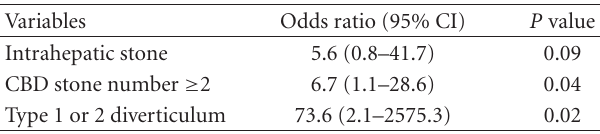
Table 3: Multivariate analysis of the risk factors for recurrence of symptomatic CBD